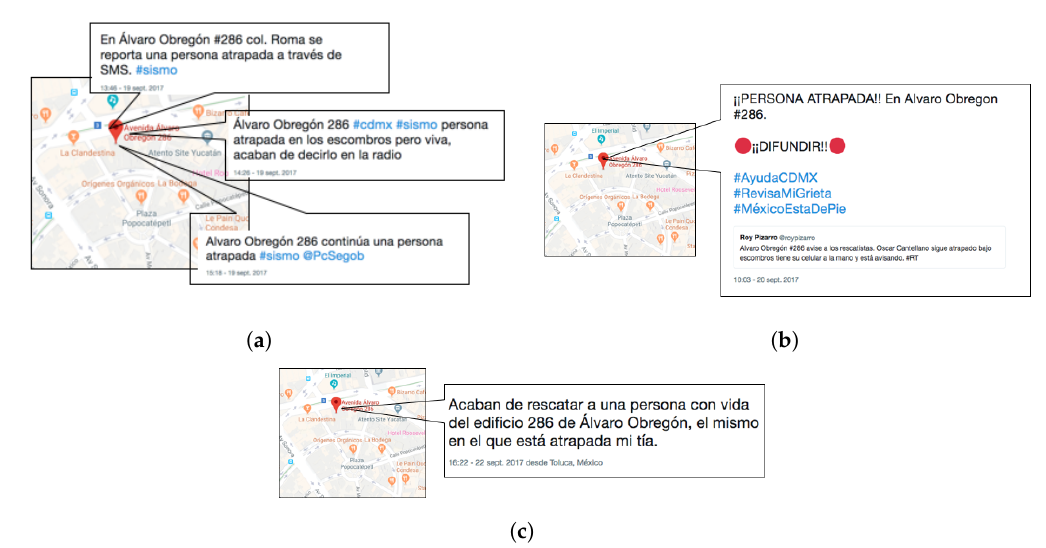
Figure 6. The first report occurs at 1:46 p.m., almost half an hour after the earthquake. The localized entity corresponds to the street Av. Álvaro Obregón , number 286, with geographic coordinates 19.4162205, − 99.1705947. The other classified entities are similar and ordered temporally until the last report at 4:22 p.m. on the third observation day. ( a ) Users first report that a person is trapped in a